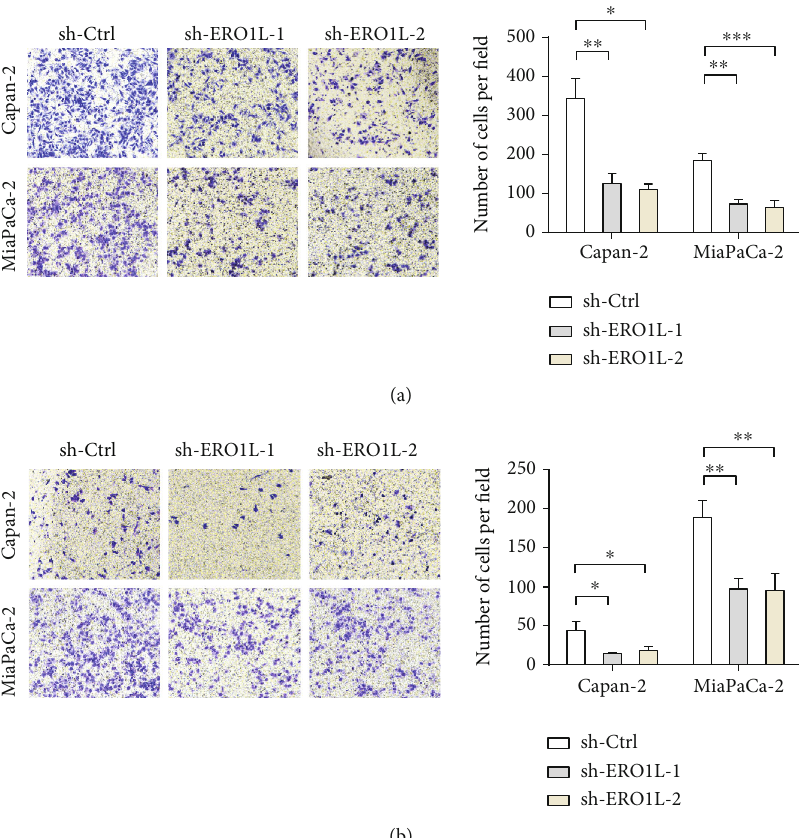
Figure 2: Genetic silencing inhibition of ERO1L suppresses migration and invasion of PDAC in vitro. (a) Transwell assays without coated Matrigel showing the role of ERO1L knockdown in PDAC cell migration in vitro. (b) Transwell assays with coated Matrigel showing the role of ERO1L knockdown in PDAC cell invasion in